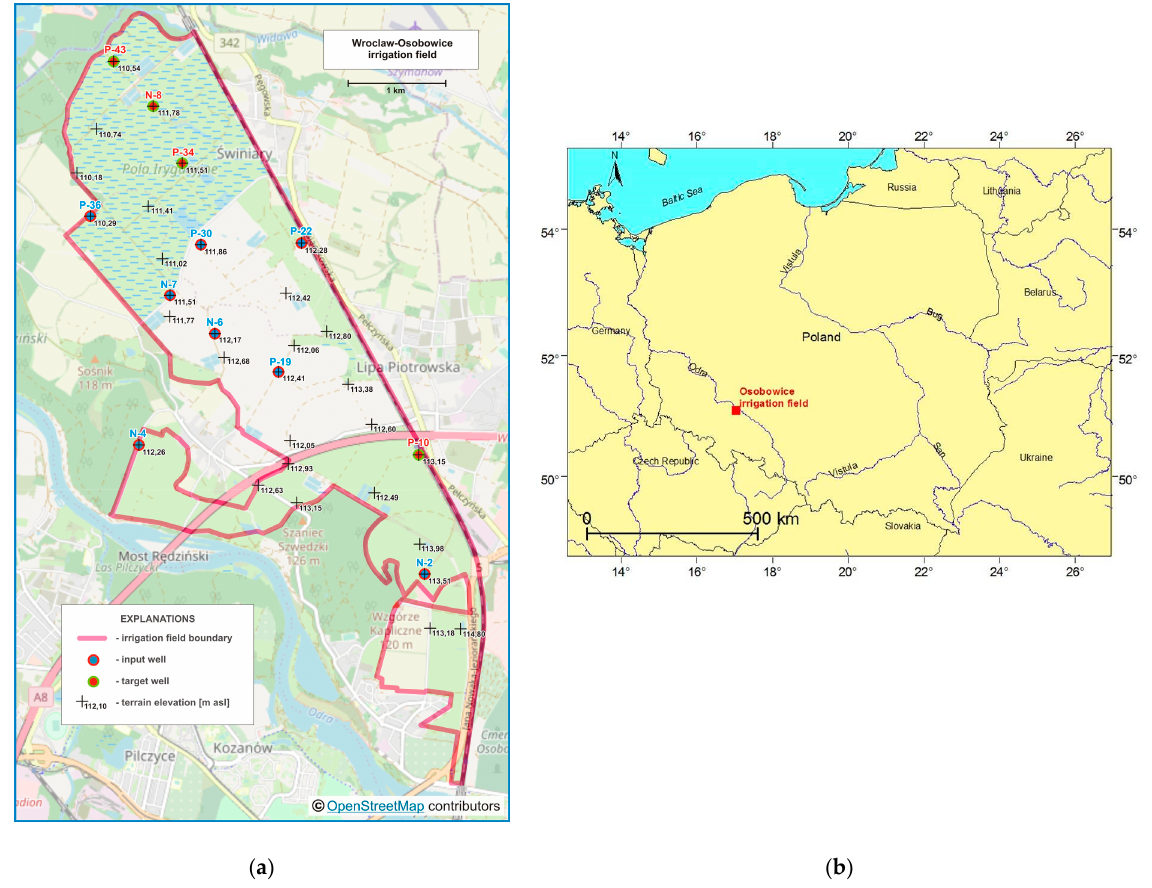
Figure 1. Wroc ł aw-Osobowice irrigation field: ( a ) location of wells; ( b ) location in Poland. Figure 1. Wrocław-Osobowice irrigation field: ( a ) location of wells; ( b ) location in